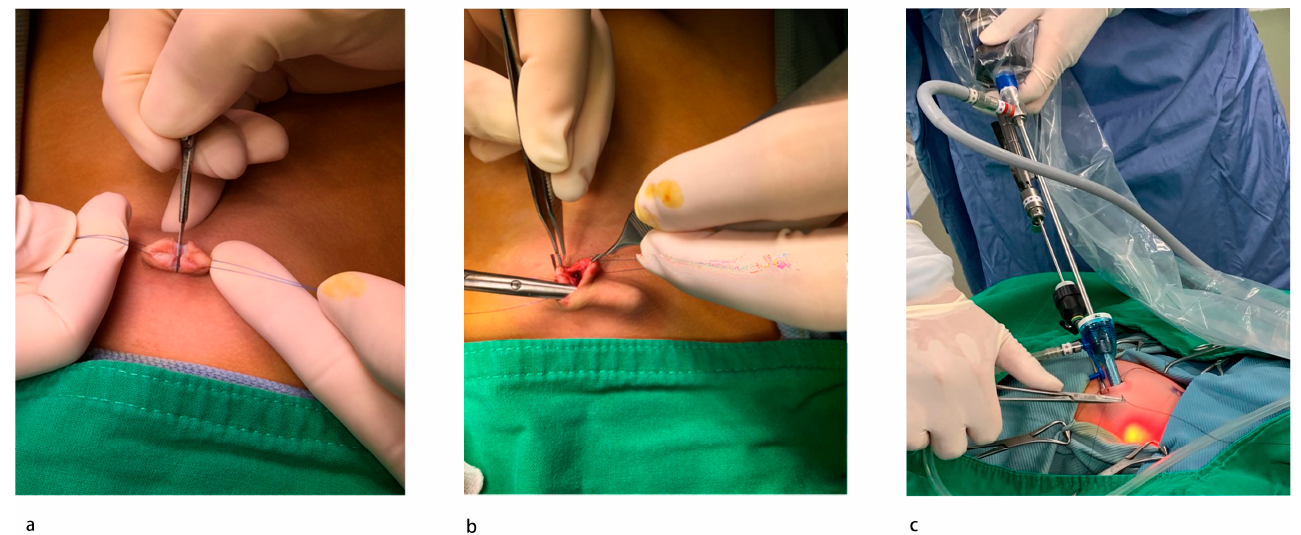
Figure 1. Single-incision laparoscopic herniorrhaphy setup: ( a ) make a midline incision on the umbilicus with stay sutures bilaterally; ( b ) create a subcutaneous tunnel through the same incision; ( c ) 5 mm trocar into the central wound, a 3 mm trocar in the tunnel.